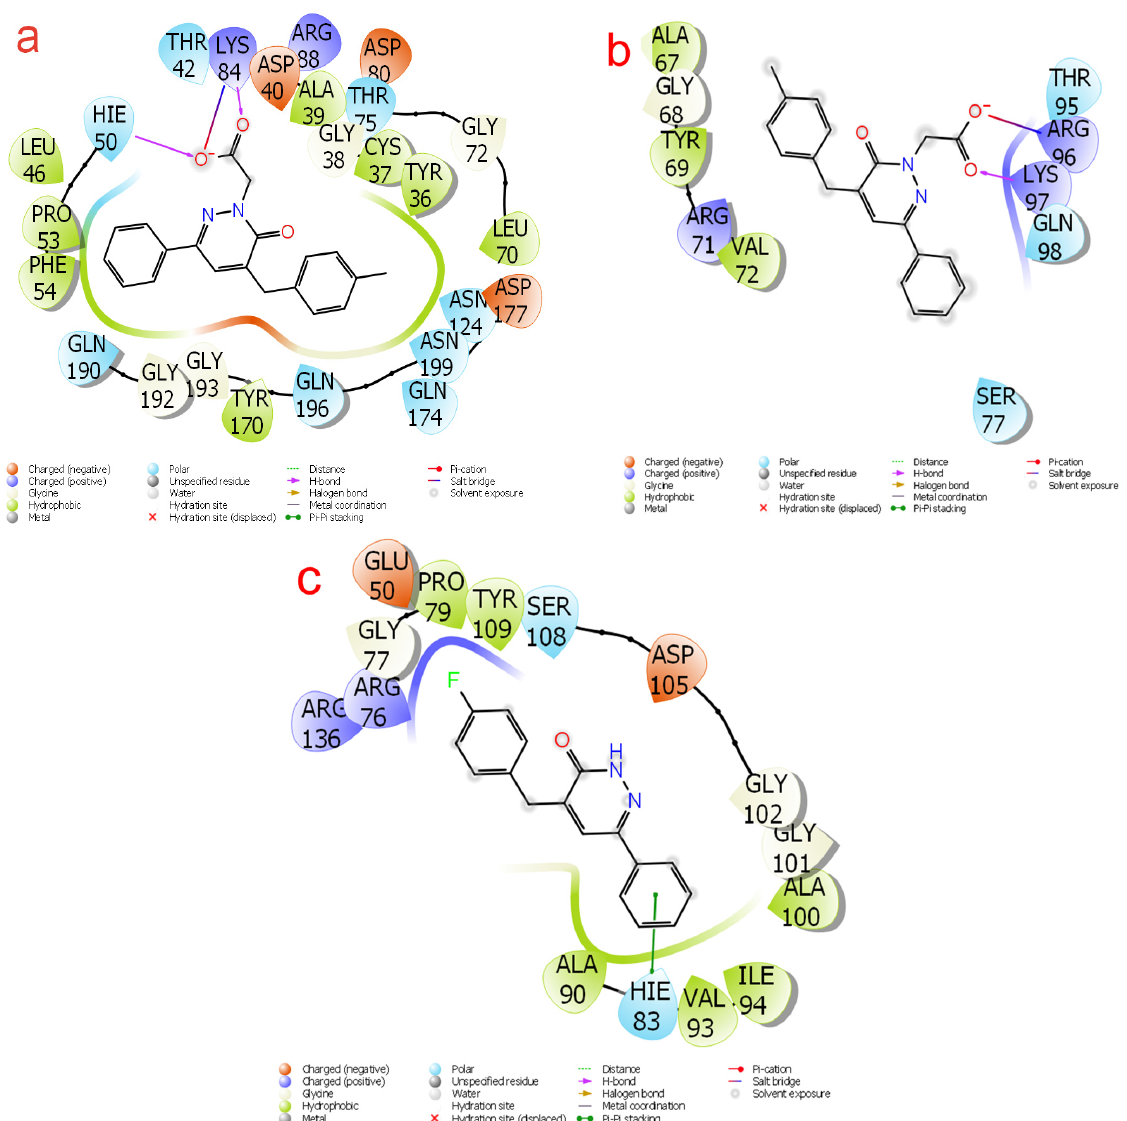
Figure 4. ( a ) Two-dimensional interaction diagram of compound 13 with 1JIJ, ( b ) two-dimensional interaction diagram of compound 13 with 2UV0, and ( c ) two-dimensional interaction diagram of compound 7 with 4WUB. Table 4. Numerical values of the docking parameters of compounds 7 and 13 against enzymes. Compound Docking Parameters (kcal/mol)